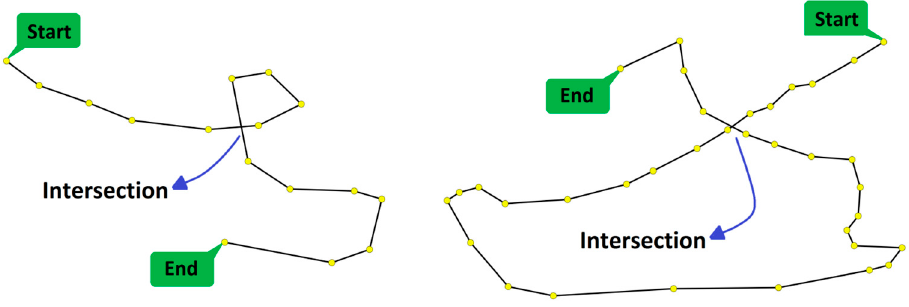
Figure 2. Self-intersecting trajectories (noise to the left, real intersection to the right).